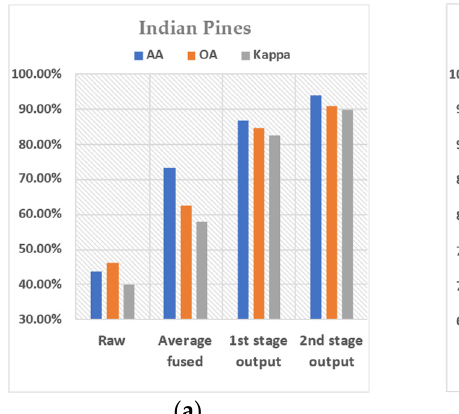
( c ) Figure 10. Analysis of the sensitivity of parameter 𝜇 in the second stage for three datasets. Classi- fication results: (a ) Indian Pines; ( b ) Salinas; ( c ) Houston University 2018. Finally, the results of sending the output feature blocks of the first and second stages directly to the classifier are shown in Figure 11. As a comparison, the results of feeding